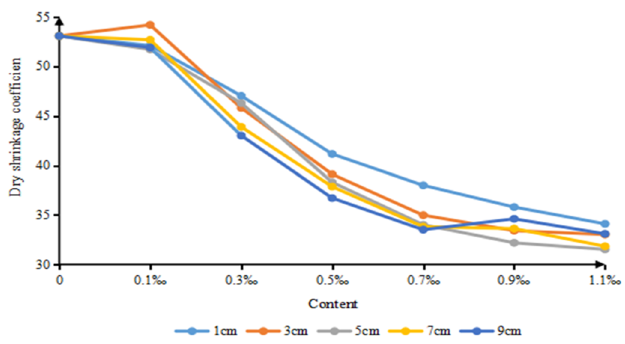
Figure 4. Effects of fiber content on the dry shrinkage coefficient.